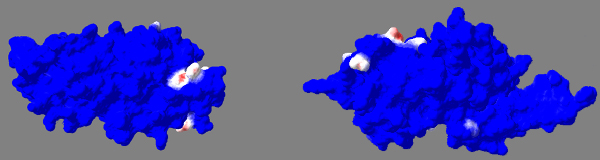
left side: molecular electrostatic potential of the viral double histone fold, in the region of putative contact between the protein and DNA. Blue surfaces correspond to repulsive regions (i.e. positively charged), while red surfaces to attractive regions (i.e. negatively charged). Right side: molecular electrostatic potential of the nucleosomal histone dimer H3-H4, in the region of contact between the dimer and DNA.